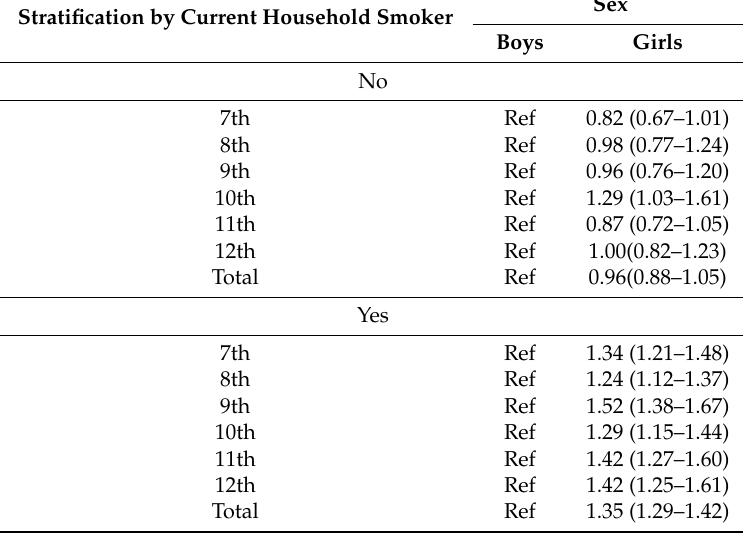
Table 4. The current household smoker-stratified adjusted odds ratios a (95% confidence interval) for exposure to second-hand smoke at home according to sex by